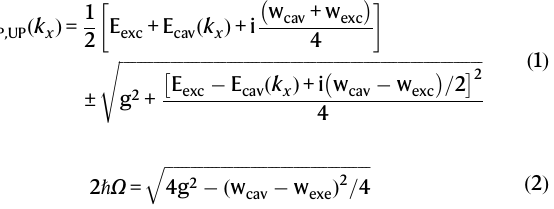
Fig. 4 | Strong coupling between D/MoSe 2 /D MML excitons and 1D photonic crystals(PCs).a Schematicofthree1DsiliconnitridePCs(yellow)withaD/MoSe 2 / D MML placed on top (blue). Each PC is 200×100 μ m 2 in size and has about the same fi lling factor of η , total thickness of t, grating thickness of h, on the top of a SiO 2 layer with a thickness of d, but varying in the period Λ to achieve different